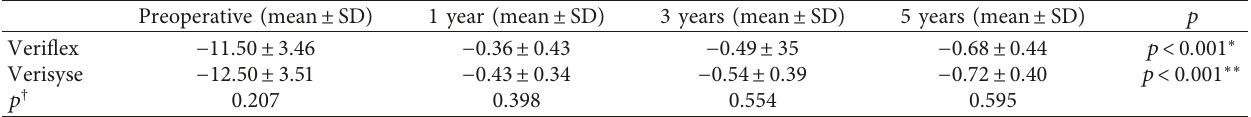
Figure 1: Cumulative uncorrected distance visual acuity in Verisyse (a) and Veriflex (b) groups. Table 2: Spherical equivalent (SE) of subjective manifest refraction during follow-up.